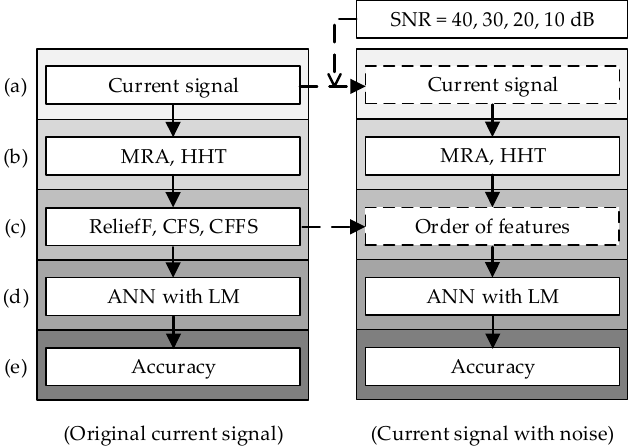
Figure 9. Schematic diagram of current signal added the noise to establish fault-detection system. ( a ) capture the observations, ( b ) build fault detection dataset, ( c ) feature selection, ( d ) train the ANN, ( e ) classification result.